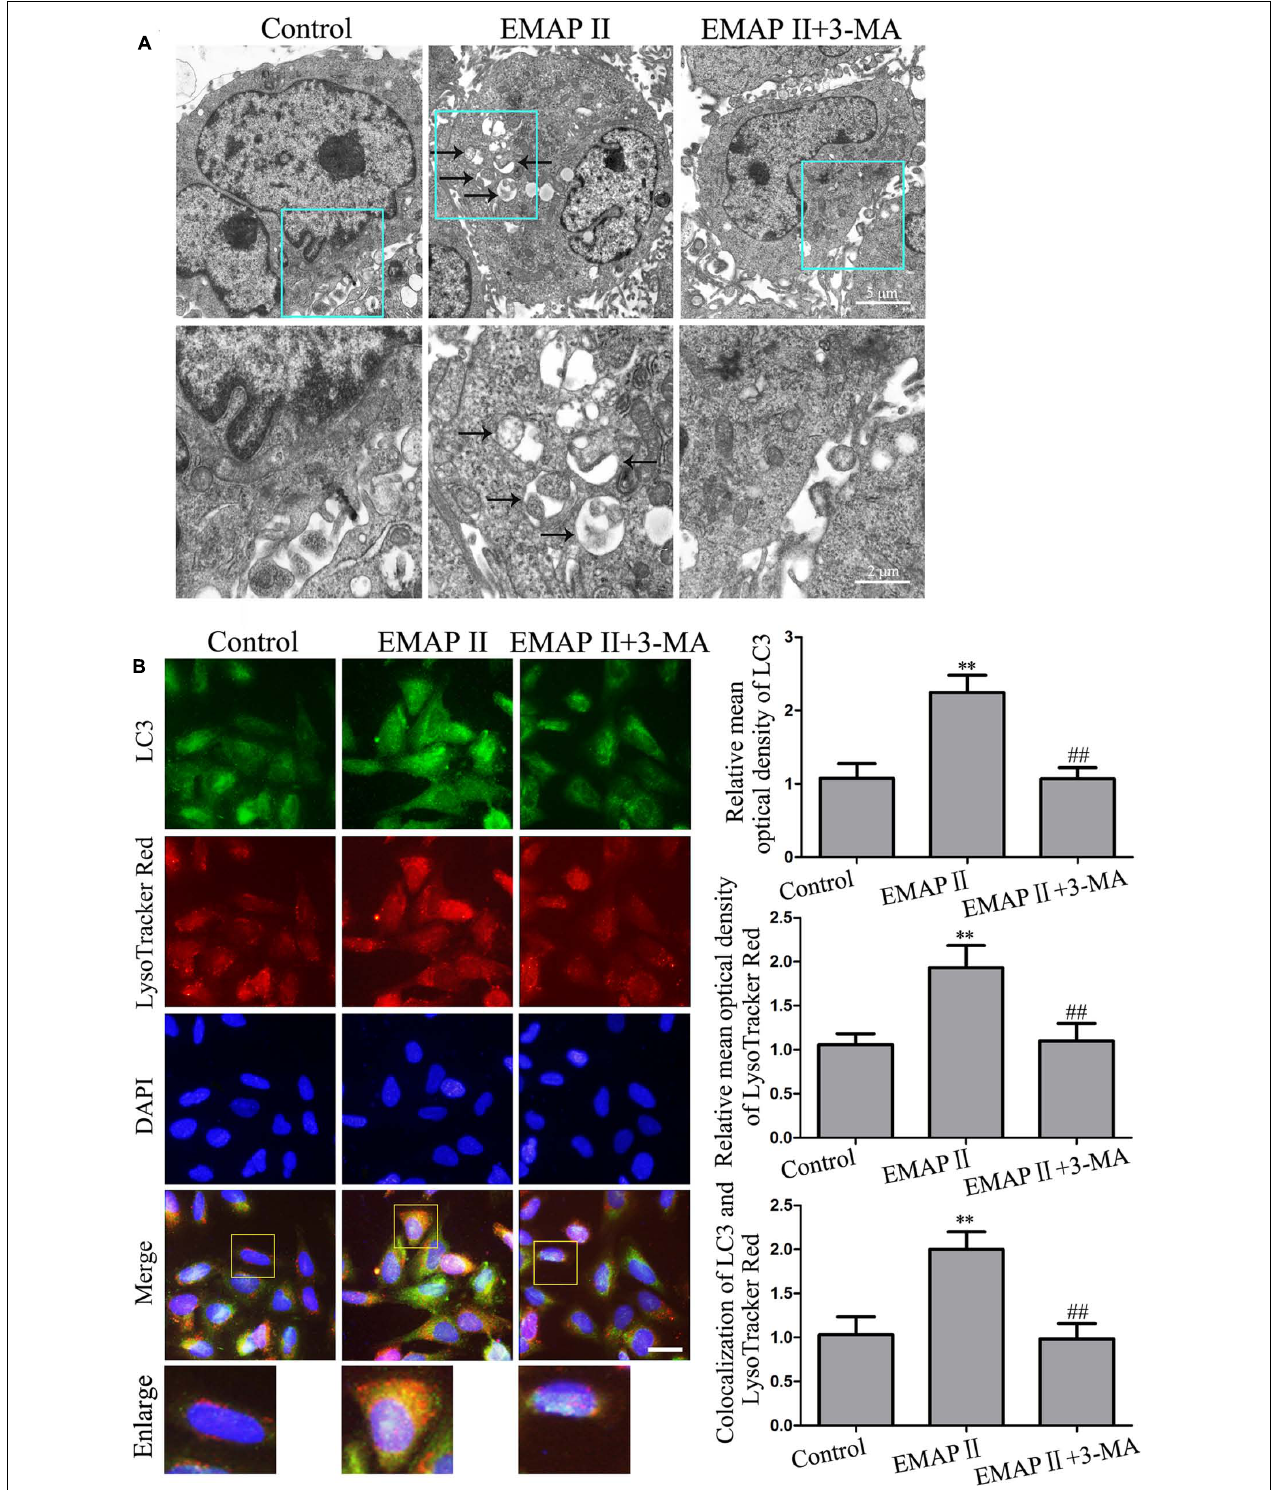
FIGURE 2 | Effect of EMAP II and 3-MA on the ultrastructural changes, LC3 and lysosomal signals in GECs. (A) Effect of EMAP II and 3-MA on the ultrastructural changes in GECs. Arrows showed autophagic vacuoles. (B) The colocalization of LC3 and LysoTracker Red in GECs. Relative mean optical density of LC3 and LysoTracker Red, and the co-localization of LC3 and LysoTracker Red quantified. Pictures are respective magnification ( n = 4, each). Scale bar = 20 µ m. ∗∗ P < 0.01 vs. control group, ## P < 0.01 vs. EMAP II group.